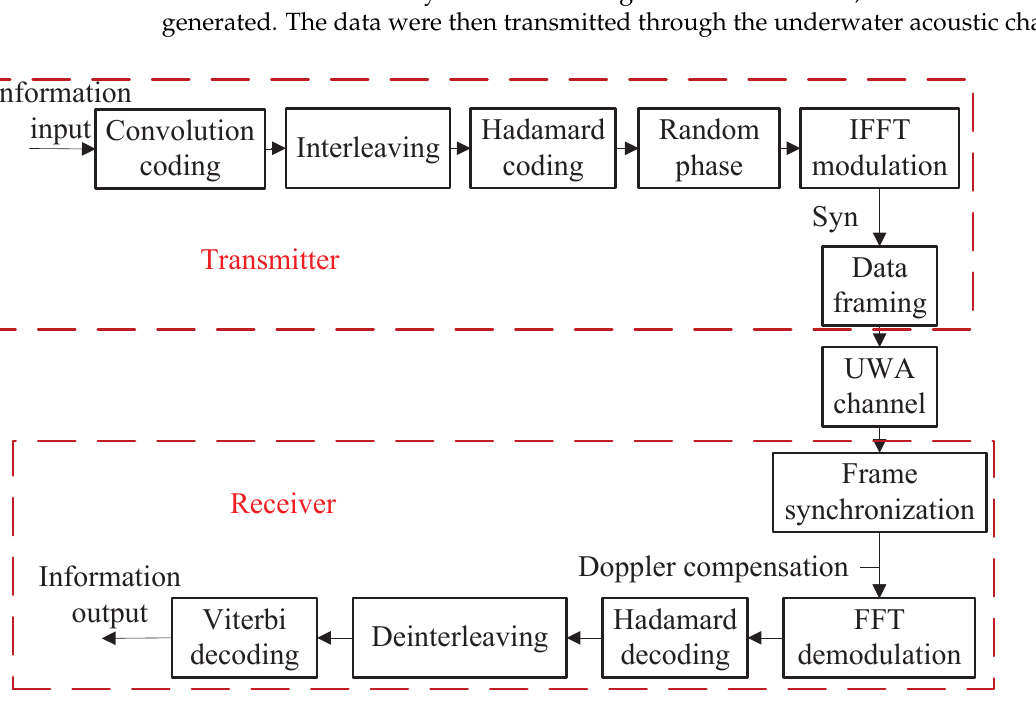
Figure 1. The block diagrams of the transmitter and the